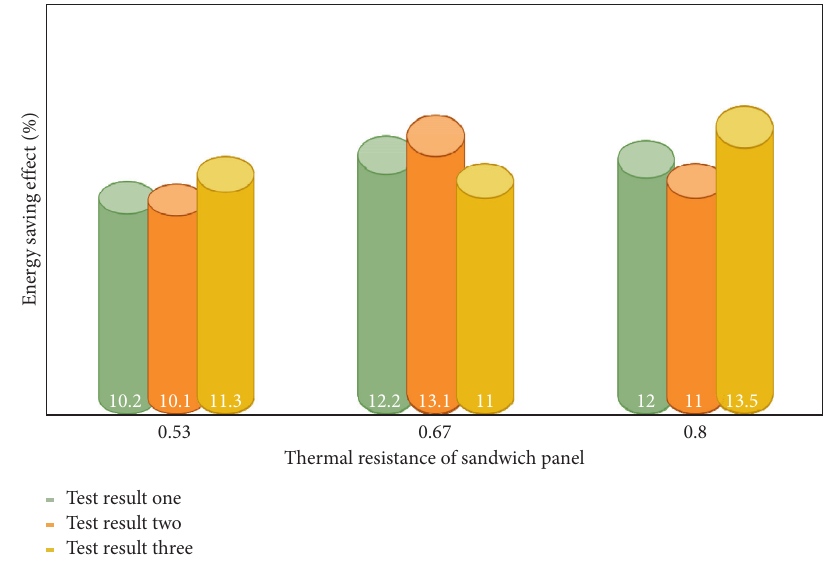
Figure 4: Energy-saving effects of different thermal resistance